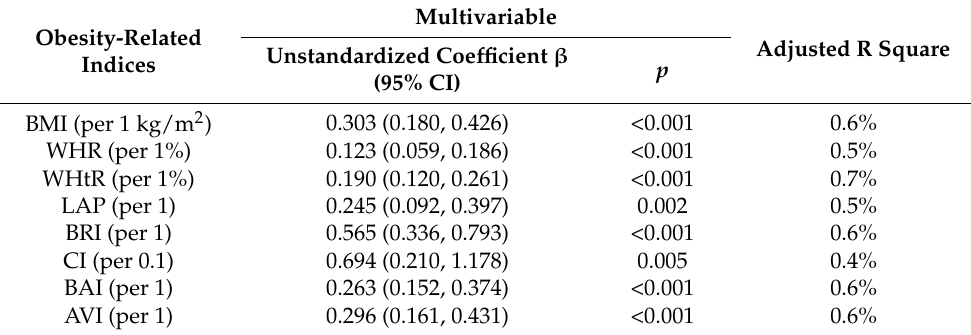
Table 3. Association of obesity-related indices with baseline FEV1/FVC using multivariable linear regression